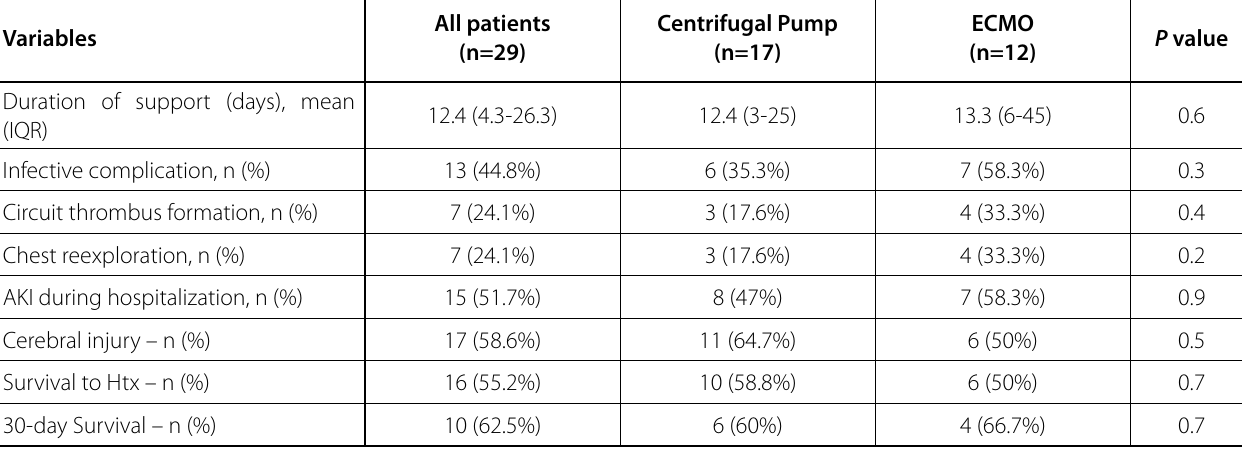
Table 2 . Pediatric and congenital heart transplant patients receiving mechanical circulatory support results comparing centrifugal pump and ECMO